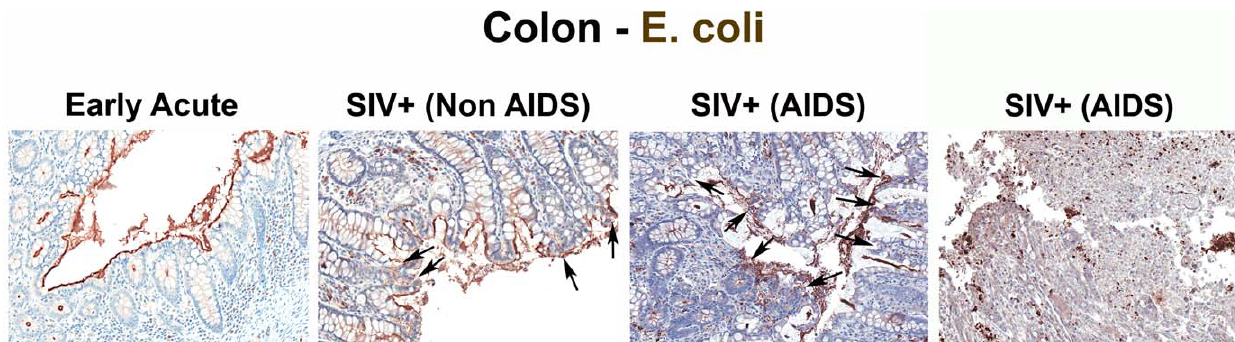
Figure 2. Identification of microbial translocation in large bowel of chronically SIV + RMs. Representative images (200 6 ) of colon stained with a polyclonal antibody against E. coli (brown) in SIV early acute infected (4 dpi) and chronically SIV-infected RMs (Non-AIDS and AIDS). Note the small regions of epithelial discontinuities in the SIV + Non-AIDS RMs resulting in luminal E. coli + content in direct contact with the LP and increased frequency of E. coli + cells within the LP. Sections from two SIV + AIDS RMs show the range of epithelial damage with associated microbial product infiltration, findings frequently seen in RMs with AIDS. Arrows point to regions of epithelial discontinuities and microbial translocation into the LP.